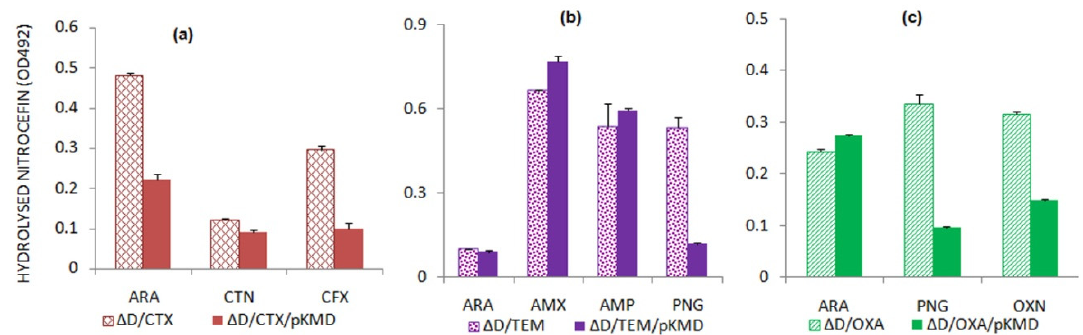
Figure 2. Relative beta-lactamase induction by arabinose and characteristic substrates of the beta- lactamases abbreviated as ( a ) CTX (CTX-M-15); ( b ) TEM (TEM-1); and ( c ) OXA (OXA- 2) in Δ ampD mutated ( Δ D) and Δ ampD complemented strains ( Δ D/pKMD) as measured by the nitrocefin hydro-